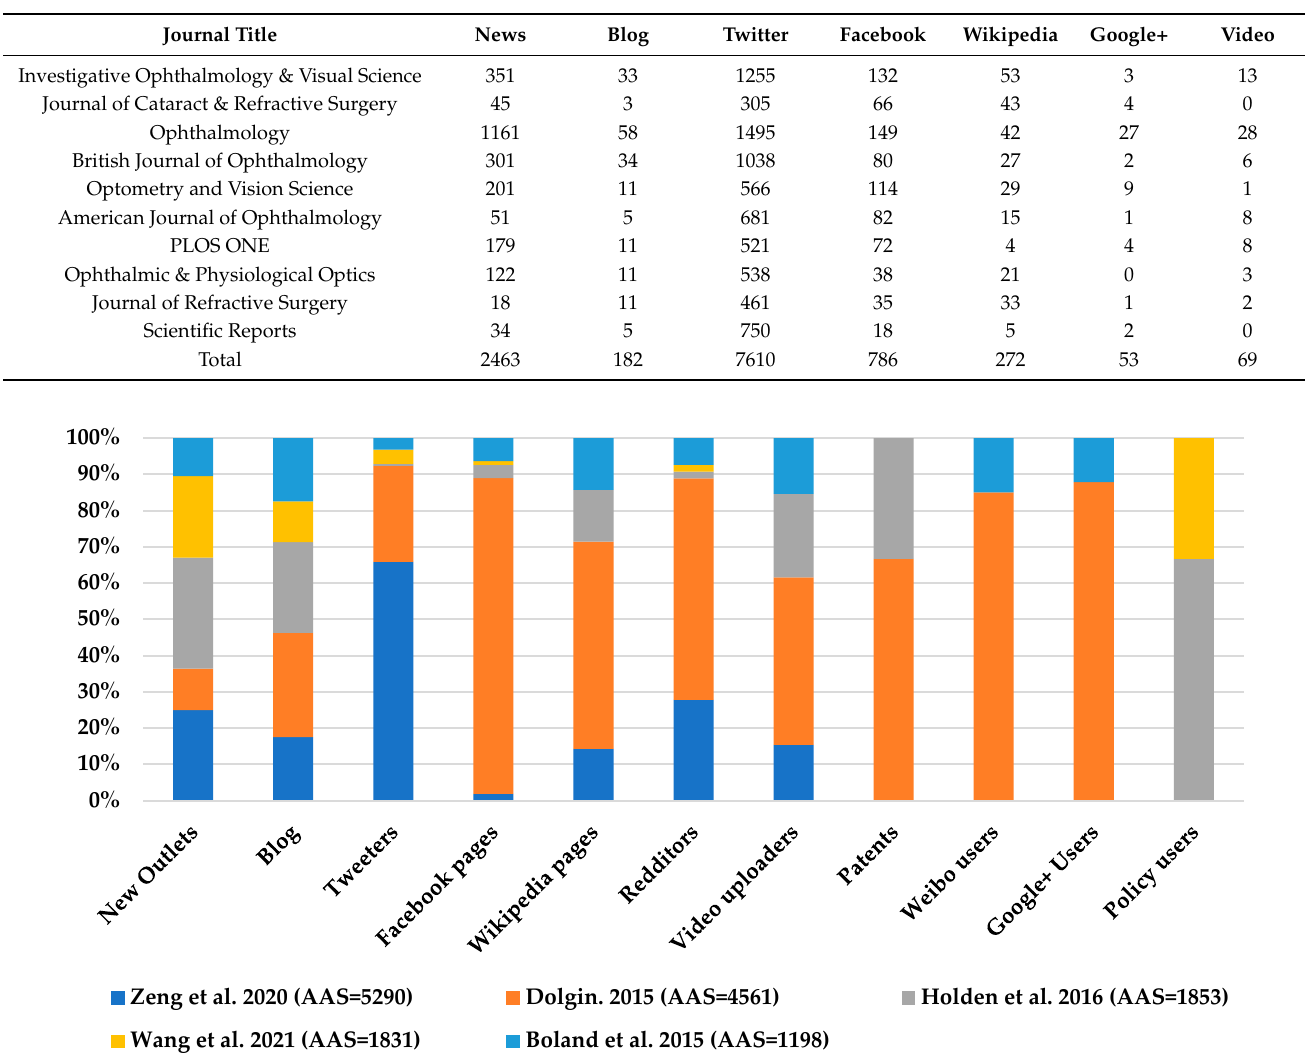
Table 3. Mention of the journals on the different social media.